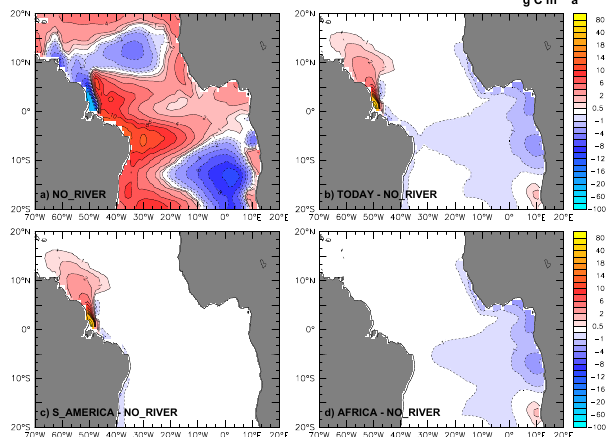
Fig. 4. Mean integrated sea-to-air CO 2 flux in gCm − 2 a − 1 (av- erage 1998–2005) for (a) the NO_RIVER scenario. Positive values denote outgassing of CO 2 from the ocean surface to the atmosphere. Plates (b) , (c) and (d) represent the difference between the TODAY, S_AMERICA and AFRICA scenarios, and the NO_RIVER sce- nario (gCm − 2 a − 1 , average 1998–2005). In these plates, red areas represent a decrease in the ocean CO 2 sink, and blue areas represent the opposite.